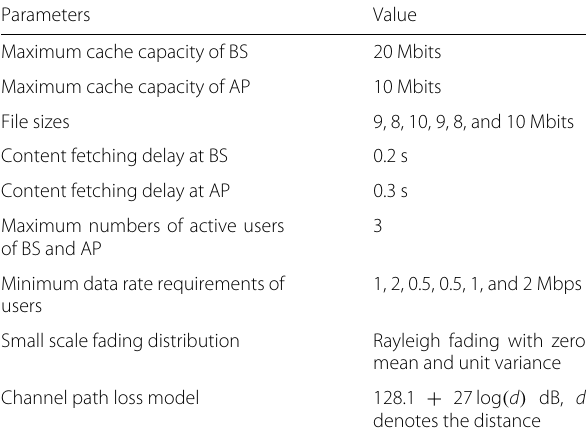
Table 1 System parameters. The system parameters considered in the simulation